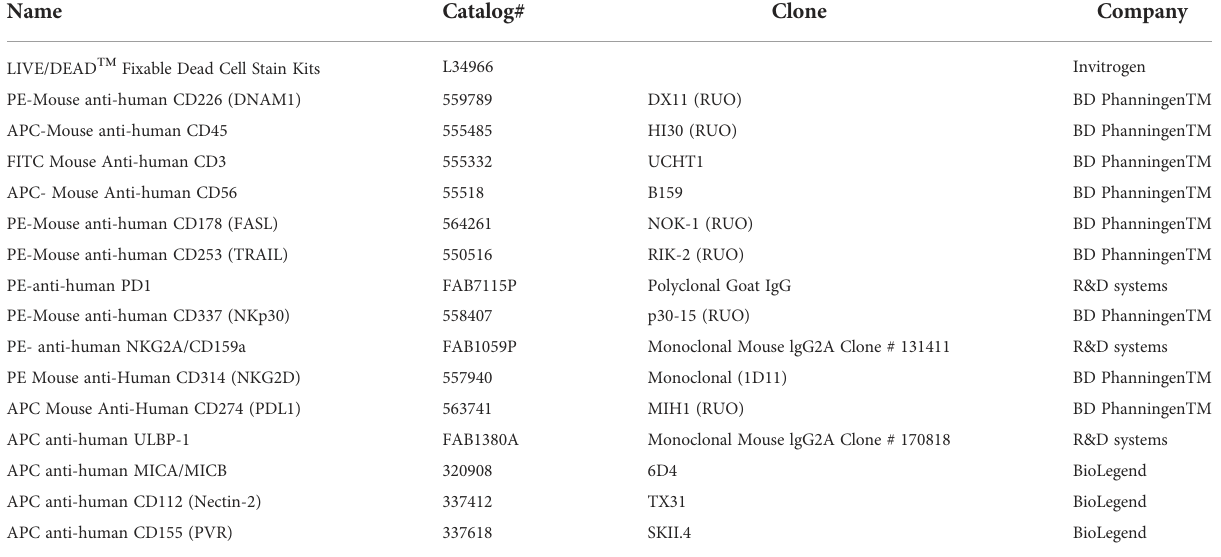
TABLE 1 List of antibodies used in fl ow